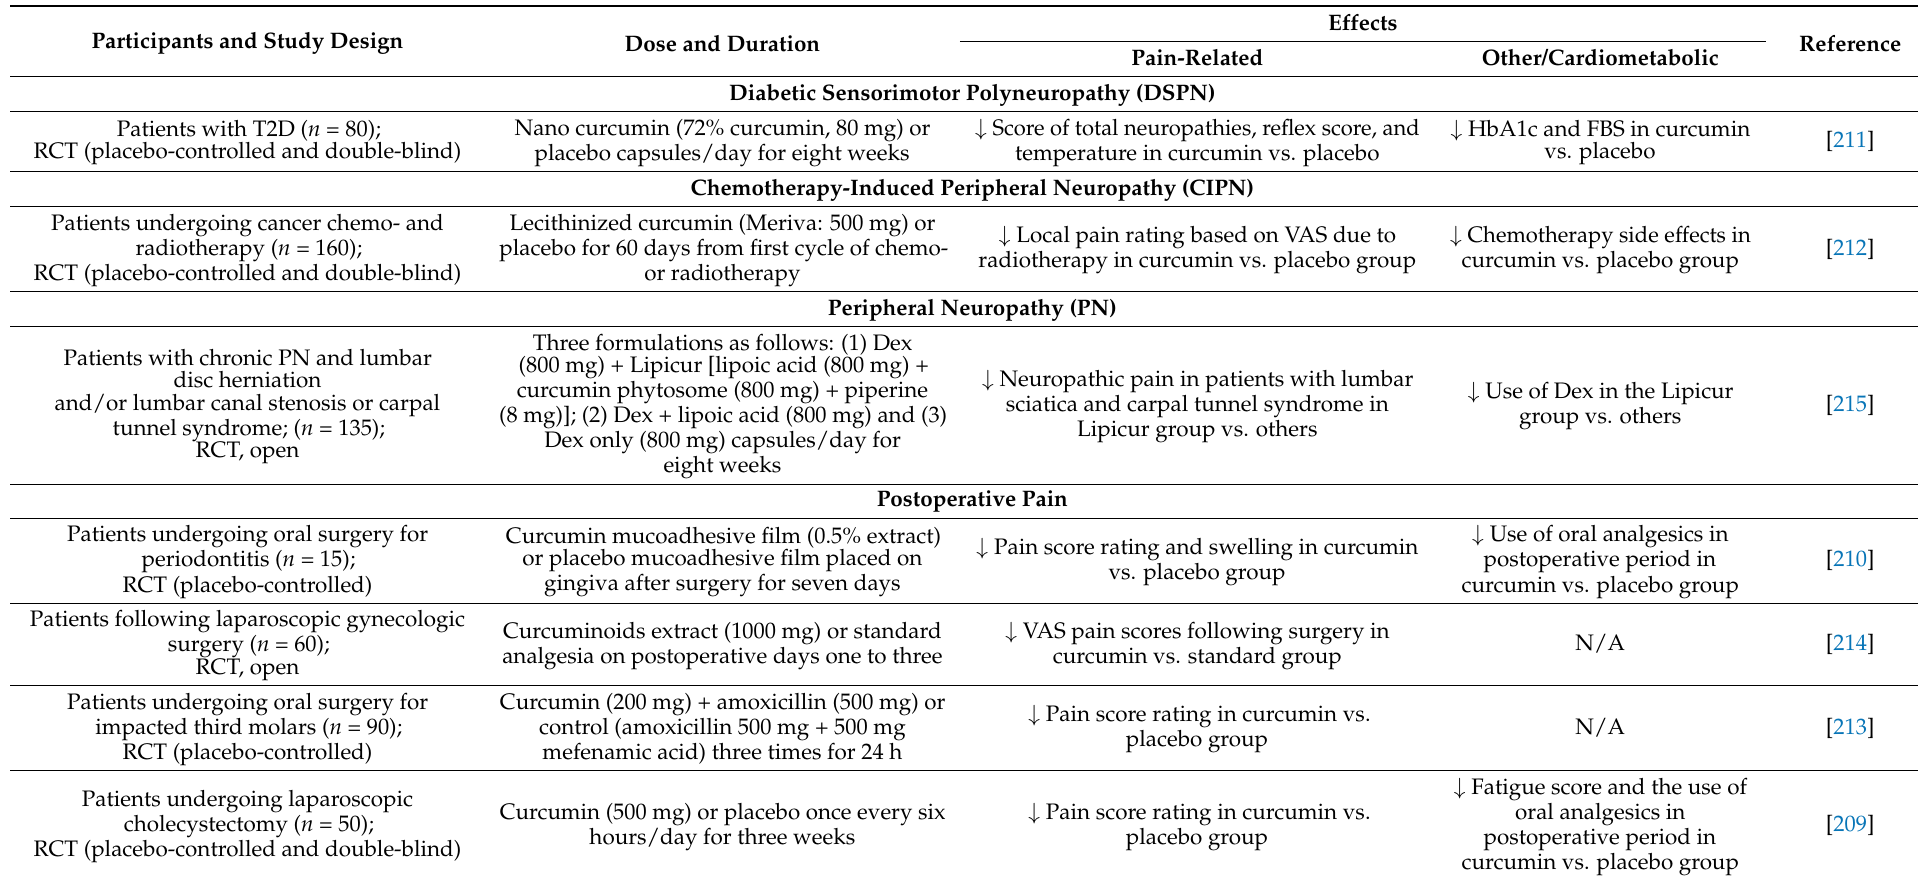
Table 7. Effects of curcumin on neuropathic pain and postoperative pain of clinical